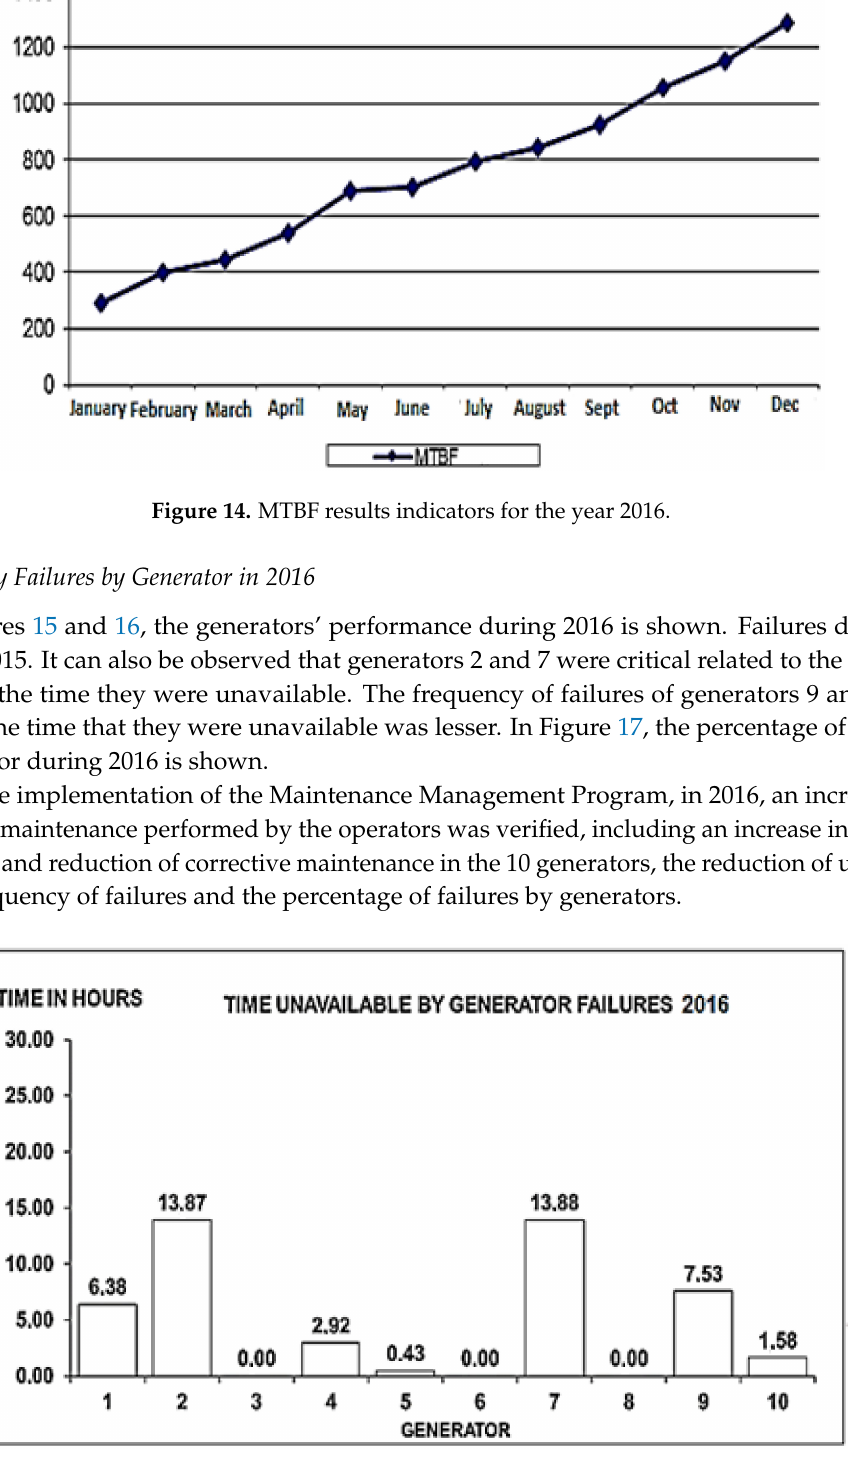
Figure 15. Indicators of the failure time results per generator